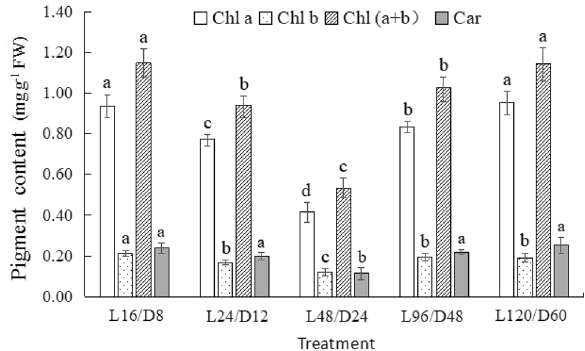
Figure 5. The Chlorophyll (Chl) and Carotenoid (Car) contents of lettuce exposed to different L/D cycle treatments of RB. Different letters for the same parameter indicate significant differences at the 5% level, according to the Tukey’s test (n = 3). The bars represent the standard errors. L/D—light/dark. L16/D8—16 h light/8 h dark (as control), L24/D12—24 h light/12 h dark, L48/D24—48 h light/24 h dark, L96/D48—96 h light/48 h dark, L120/D60—120 h light/60 h dark.